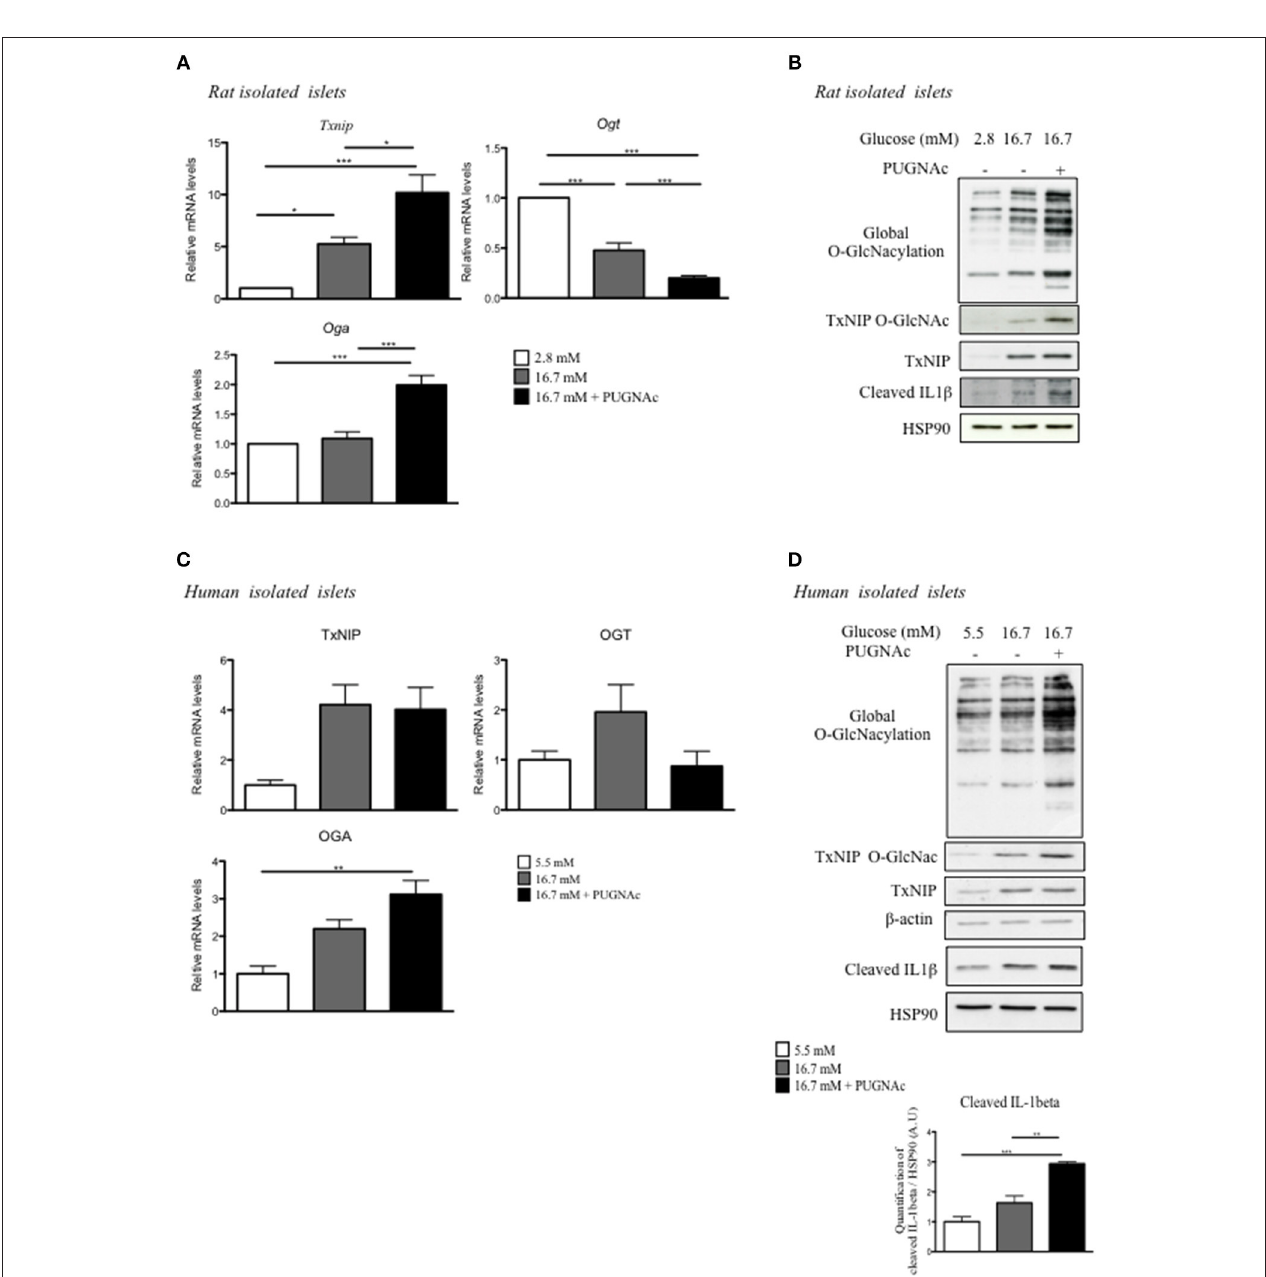
FIGURE 3 | Increasing O-GlcNAcylation in rat and human islets promotes inflammasome activation. (A,B) Islets isolated from Wistar rat were incubated for 72h under low glucose (2.8mM), high glucose (16.7mM), or high glucose plus PUGNAc (16.7mM + PUGNAc) (A) Q-PCR analysis of OGT, OGA, and TxNIP. Data are means ± SEM of eight independent experiments. Significance is based on two-way ANOVA followed by a Bonferroni post-hoc test * p < 0.05, ** p < 0.01, *** p < 0.001. (B) Global O-GlcNAcylation levels and TxNIP protein content. TxNIP O-GlcNAcylation was evaluated by WGA binding experiments. Representative Western blot for cleaved Il1 β protein content is shown. HSP90 was used as a loading control. (C,D) Human islets were incubated for 72h under low glucose (5.5mM), high glucose (16.7mM), or high glucose plus PUGNAc (16.7mM + PUGNAc) (C) QPCR analysis of TxNIP, OGT, and OGA mRNA expression. Data are means ± SEM. n = 3 independent experiments. Significance is based on two-way ANOVA followed by a Bonferroni post-hoc test ** p < 0.01. (D) Global O-GlcNAcylation levels, TxNIP protein content, and O-GlcNAcylation of TxNIP evaluated by WGA binding experiments. β -actin was used as a loading control. Representative Western Blot of Cleaved Il1 β and HSP90 are also shown. Data are means ± SEM. n = 3 independent cultures. Significance is based on two-way ANOVA followed by a Bonferroni post-hoc test ** p < 0.01, *** p < 0.001.